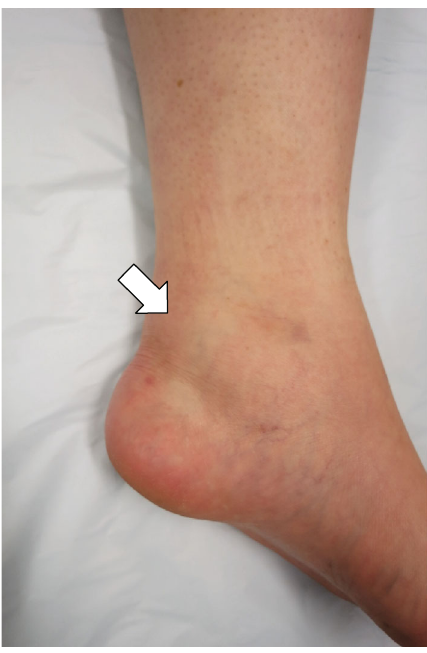
Figure 1: Preoperative photograph showing swelling of the posteromedial side of the left ankle (white arrow).